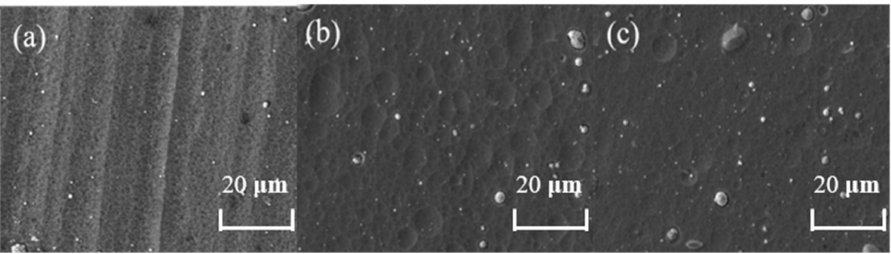
Figure 4. Surface morphology of ( a ) Cr, ( b ) CrN, and ( c ) Cr 2 N coatings. The cross-sectional morphologies of the Cr-N x coatings are shown in Figure 5. The coatings deposited with the selected parameters were dense and smooth. No signs of defects, such as pores inside the layer, were observed. Moreover, the coatings that were not peeled off or cracked were well integrated with the substrate. The average thicknesses of the Cr, CrN, and Cr 2 N coatings were 7.76, 21.05, and 12.16 µ m, respectively. For the same deposition time of 6 h, the thickness of the CrN coating was higher than that of the Cr 2 N coating. Hence, it can be concluded that an increase in the amount of nitrogen introduced can accelerate the deposition rate of the Cr-N x coatings on the surface of the Zr-4 alloy. Additionally, we observed a thin Cr transition layer between the Cr-N x coatings and substrate material. The presence of the transition layer can overcome the problem of coating adhesion, considering that CrN and Cr 2 N pertain to ceramic coatings while Zr-4 alloy belongs to the metal category. Therefore, the Cr transition layer formed a reasonable composition gradient distribution, which reduces the residual stress between the interface and improves the bonding strength of the CrN and Cr 2 N coatings.